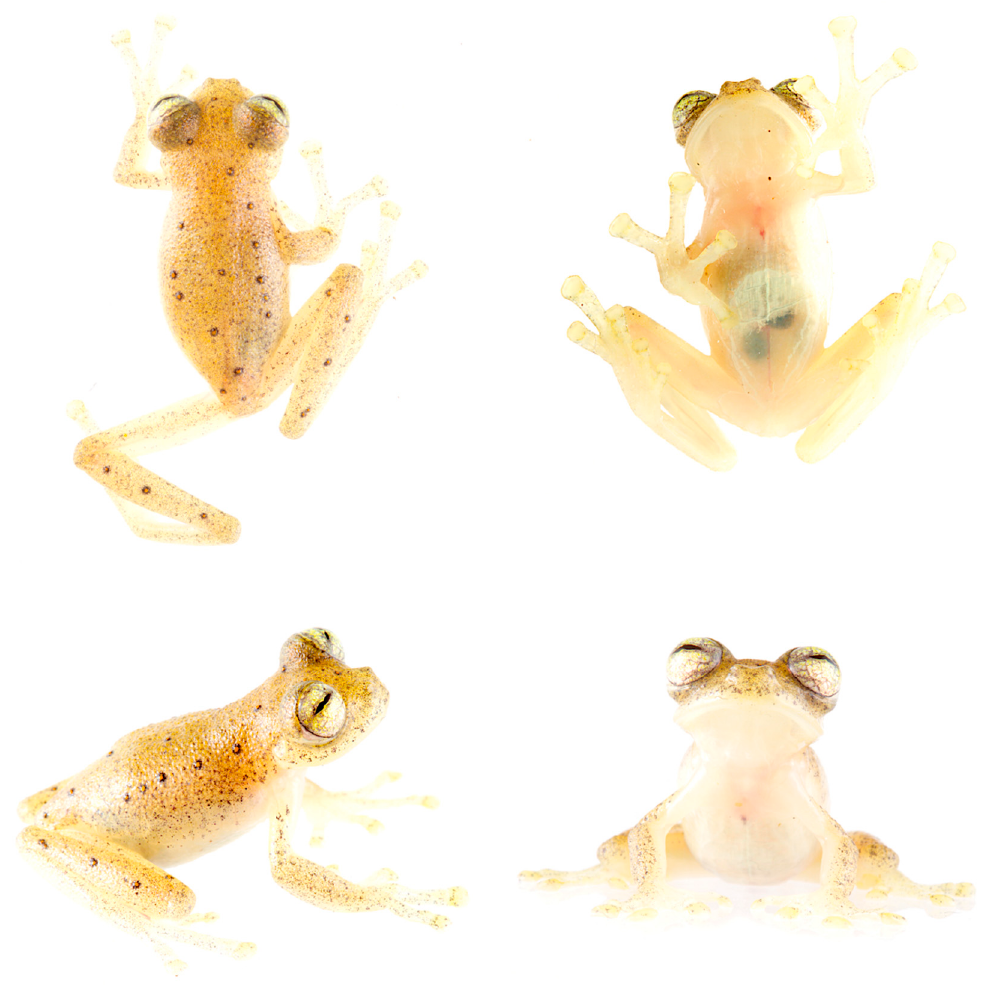
Figure 127. Nymphargus anomalus in life, ZSFQ 2123, from a tributary of Río San Jacinto, 1672 m, Tungurahua province. Photos by Jose Vieira/Tropical Herping.